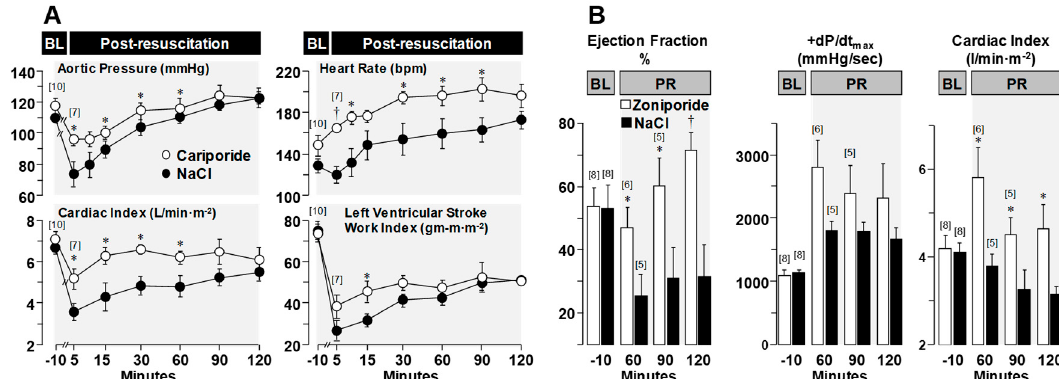
Figure 6. Baseline (BL) and post-resuscitation (PR) left ventricular and hemodynamic function. Numbers in brackets indicate sample size. Values are mean ± SEM. ( A ) Closed-chest swine model of VF and conventional cardiopulmonary resuscitation in which 20 pigs were randomized to receive cariporide or NaCl control during resuscitation from VF. * p < 0.05; † p < 0.001 vs. control by one-way ANOVA (adapted with permission from Ayoub et al. [21]). ( B ) Open-chest swine model of VF and resuscitation by extracorporeal circulation in which 16 pigs were randomized to receive zoniporide or NaCl control during resuscitation from VF. * p < 0.05, † p < 0.01 vs. NaCl. In both series administration of the NHE-1 inhibitor during cardiopulmonary resuscitation had a marked beneficial e ff ect on post-resuscitation myocardial function (adapted with permission from Ayoub et al.